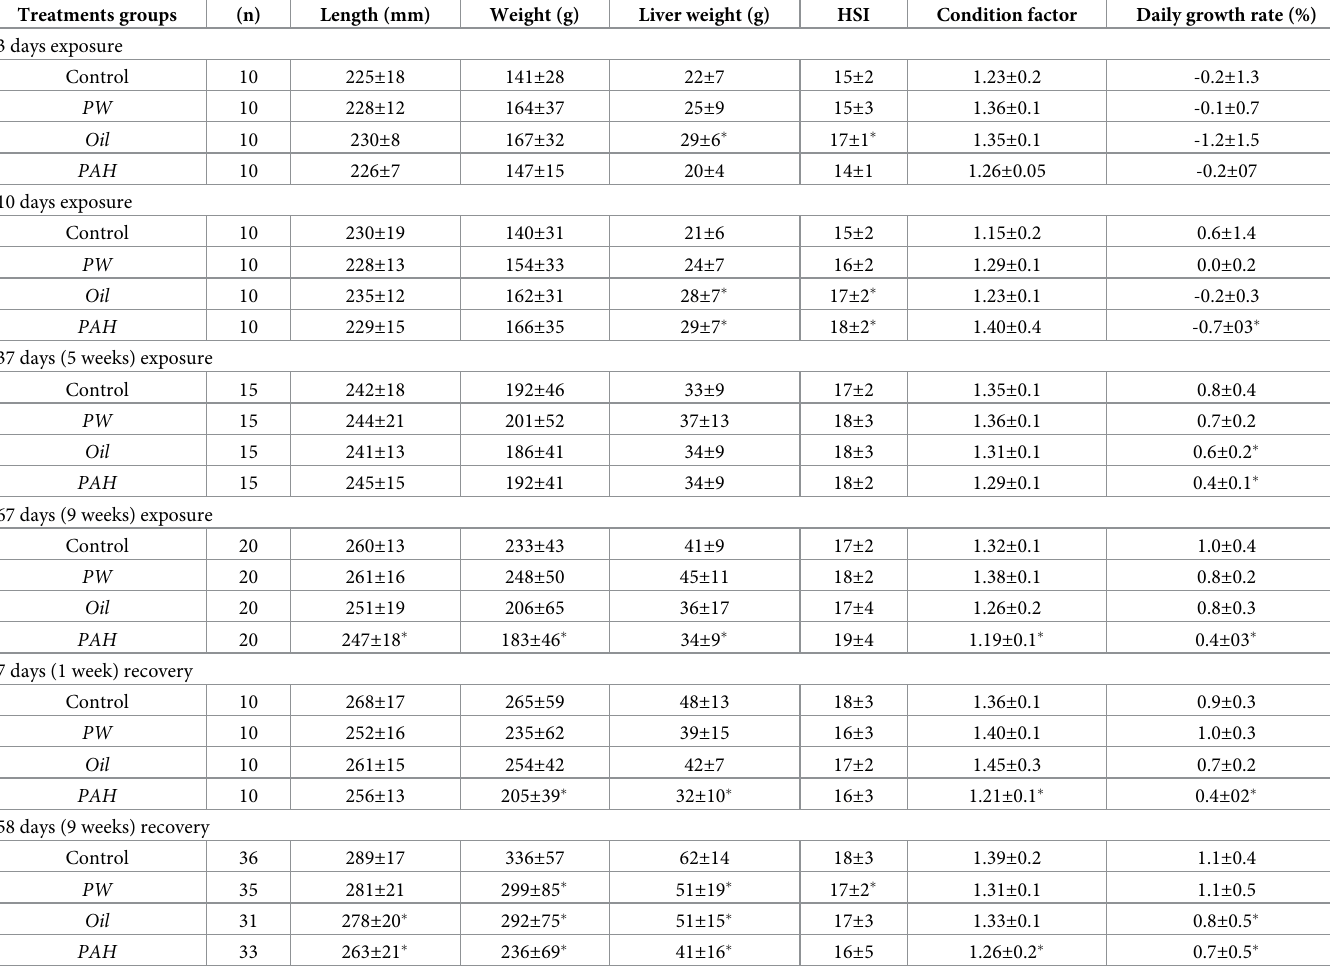
Table 3. Length, weight, liver weight, hepatosomatic index (HSI) a ; condition factor b and daily growth rate (average daily weight increase since exposure start 14.02) for all treatment groups. Treatments